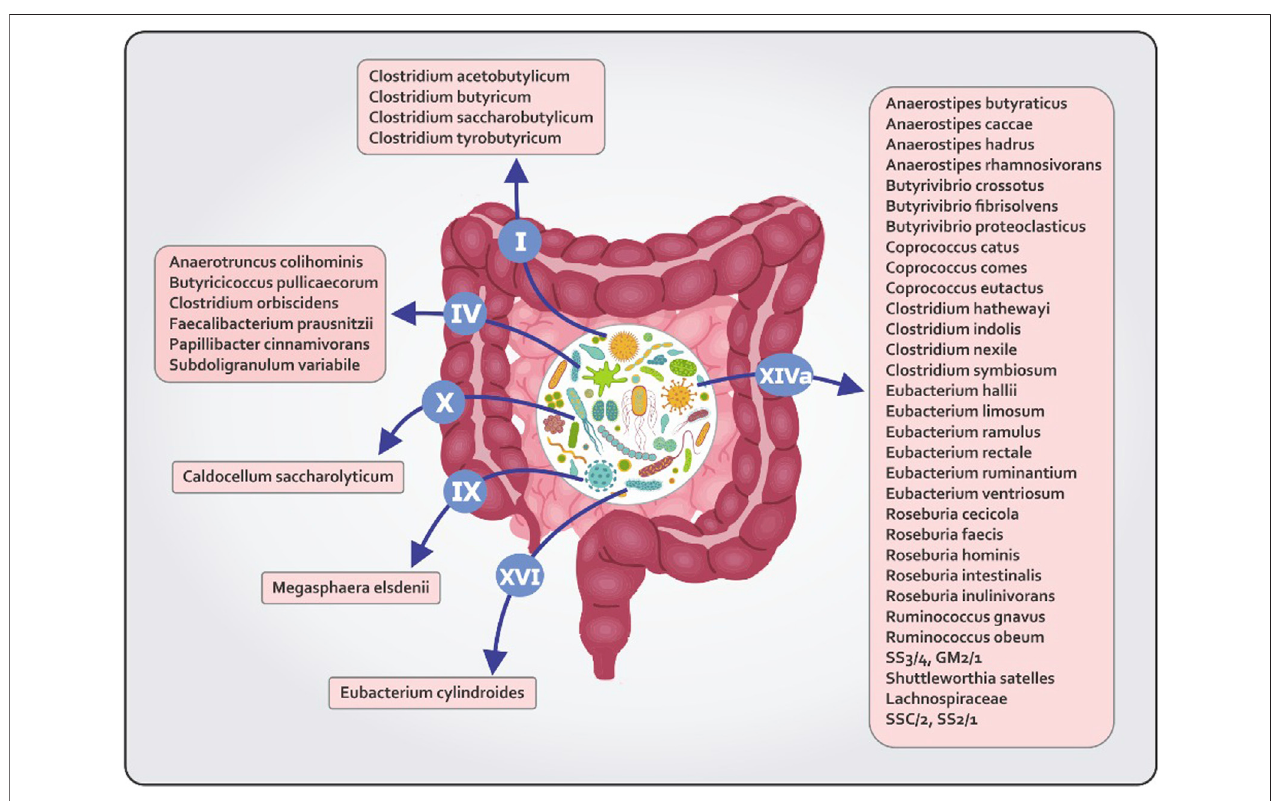
FIGURE 1 | All butyrate producing bacteria in different clostridial